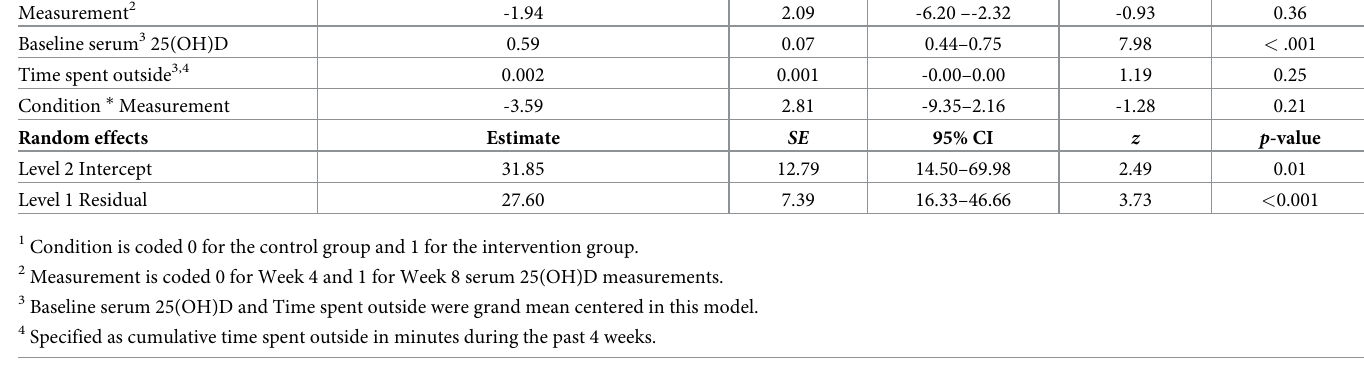
expected, there was a significant positive relationship between baseline serum 25(OH)D and subsequent measures of serum 25(OH)D. Fig 2 visualizes the change in serum 25(OH)D over time for both groups using the values calculated from this model. At Week 4, the intervention group had–on average–a higher serum 25(OH)D than the control group (mean differ- ence = 3.30; SE = 2.99; 95% CI -2.73–9.33), but this difference did not reach statistical signifi- cance ( p = 0.28). The difference between the groups at Week 8 was also non-significant (mean difference = -0.29; SE = 2.99; 95% CI -6.31–5.73; p = 0.92).